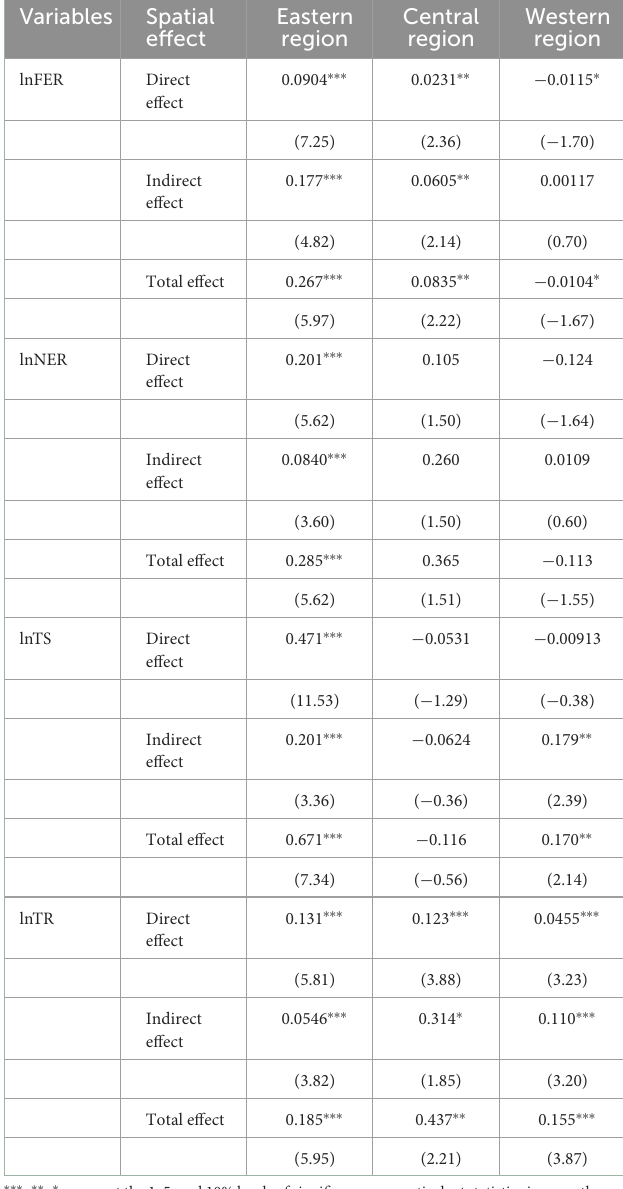
TABLE 7 Spatial effect decomposition by